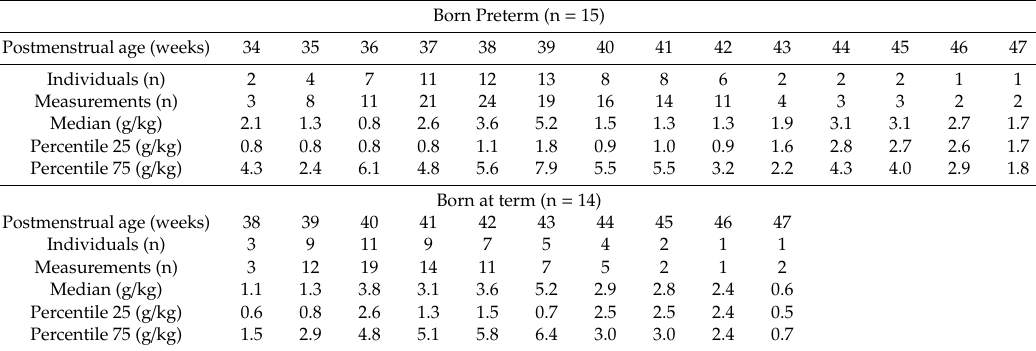
Table 4. Daily fat intake in infants born preterm and at term. Born Preterm (n =